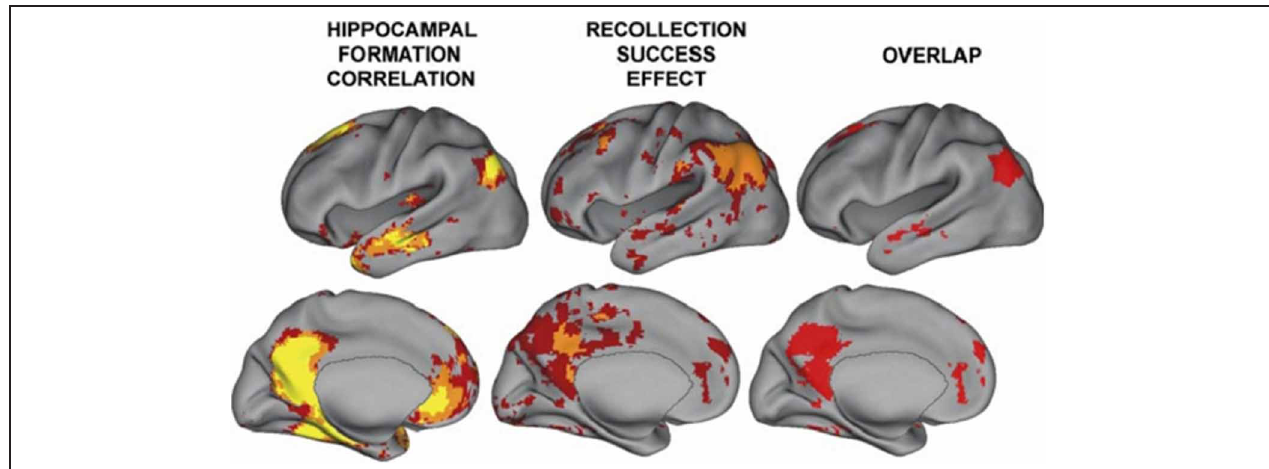
FIGURE 2 | From Vincent et al. (2006); regions correlated with hippocampal activity in resting state (note that activity is bilateral). These regions overlap with those showing activity related to recollective success. Figure 8 from the paper Vincent et al. (2006). Disclaimer: this is an